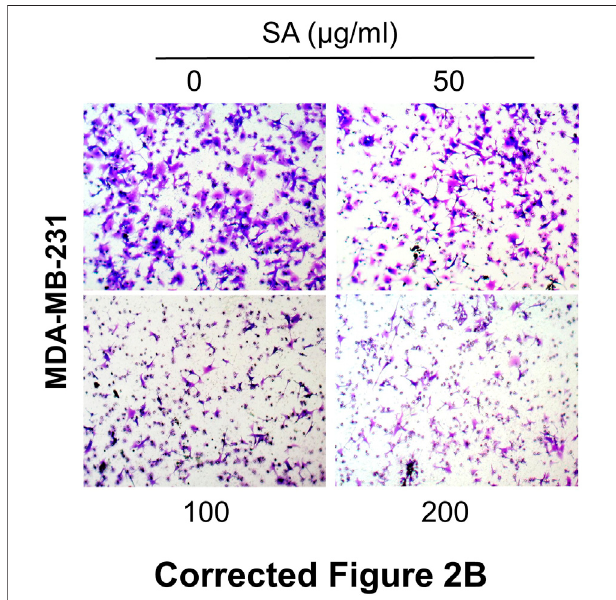
FIGURE 2 | SA suppresses migration and invasion in metastatic cells. (B) Representative images of decreased cell number in transwell chambers with or without SA (0 – 200 μ g/ml).